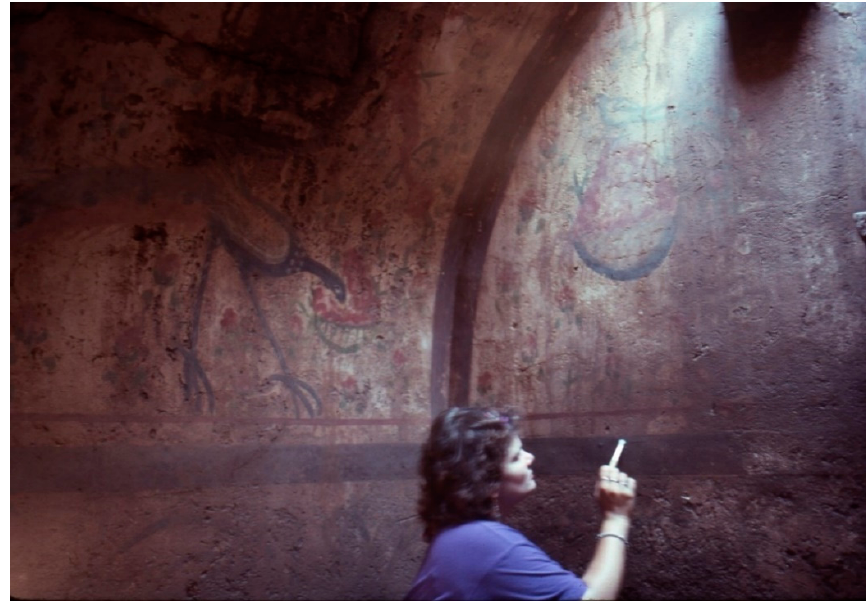
Figure A5. Sardis, Tomb 93.1 (Appendix A.4), northeast corner. © Archaeological Exploration of Sardis/President and fellows of Harvard College.